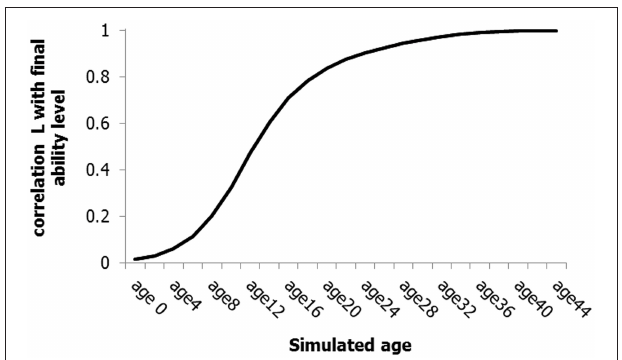
FIGURE 5 | Correlations between the final ability level and earlier levels based on a set of 1000 simulated life spans. For simplicity, the simulation steps are expressed in terms of